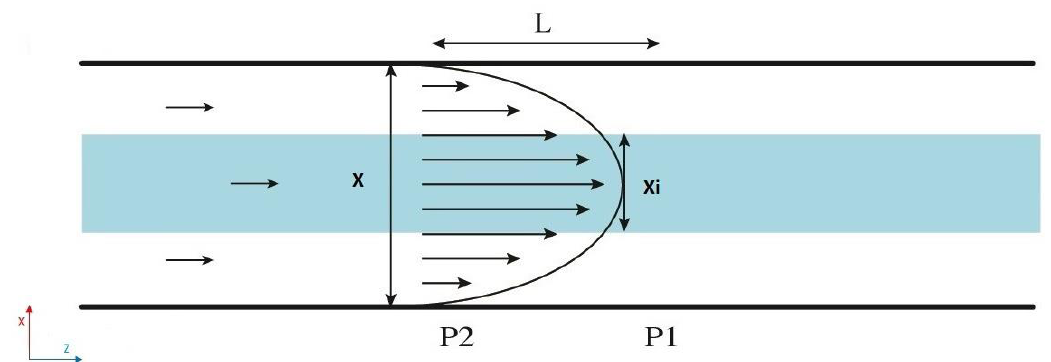
Figure 2. ( left ) Image of the polydimethylsiloxane (PDMS) microfluidic device structure once